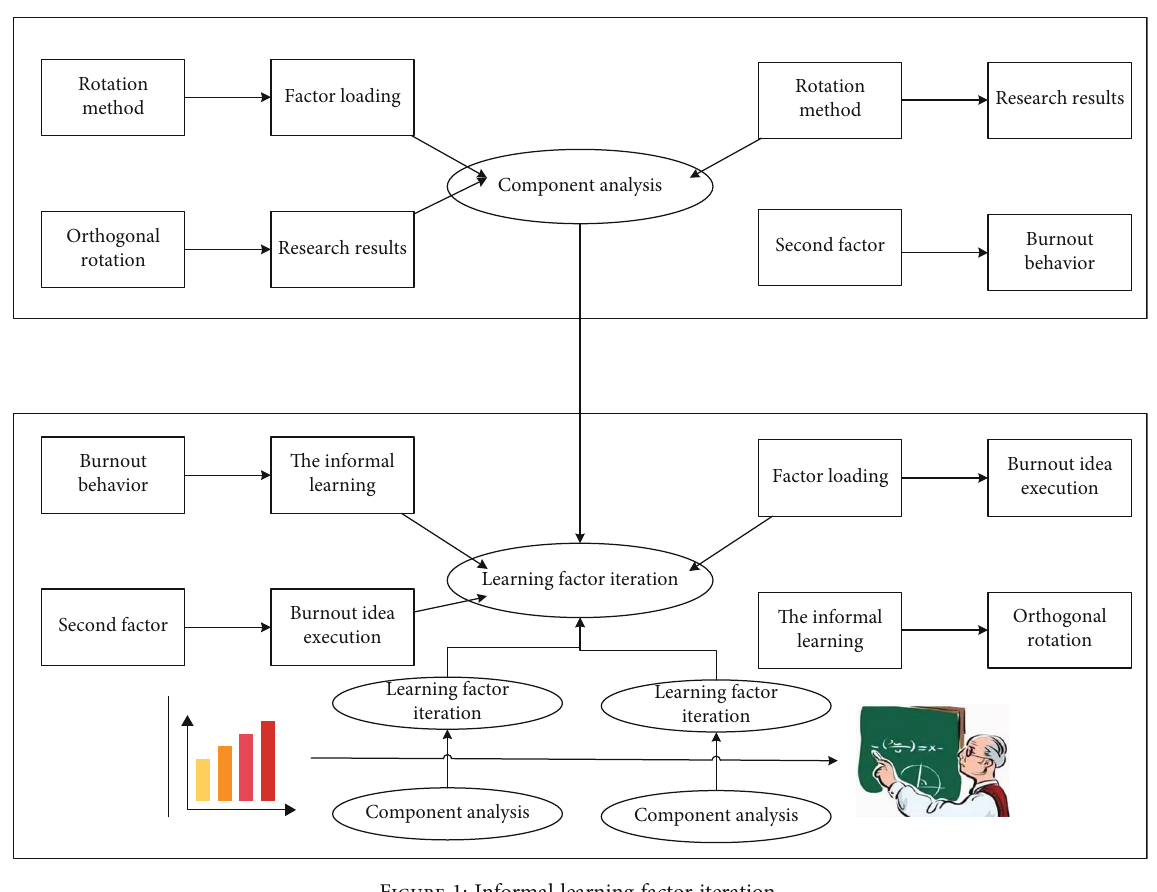
Figure 1: Informal learning factor